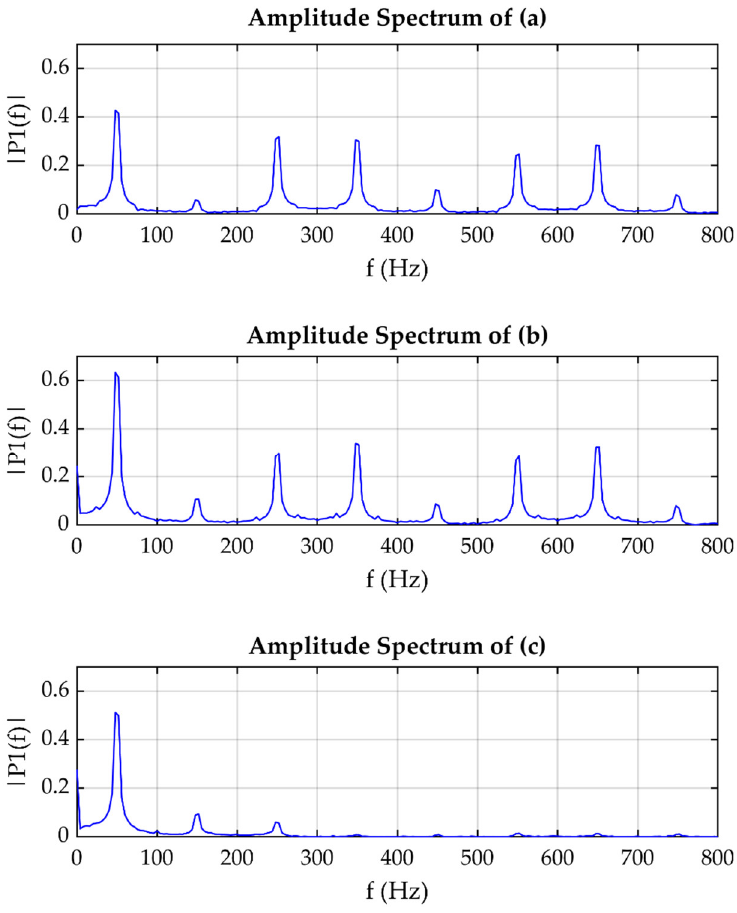
Figure 15. Frequency spectrum plots of the signals corresponding to ( a – c ) are shown.